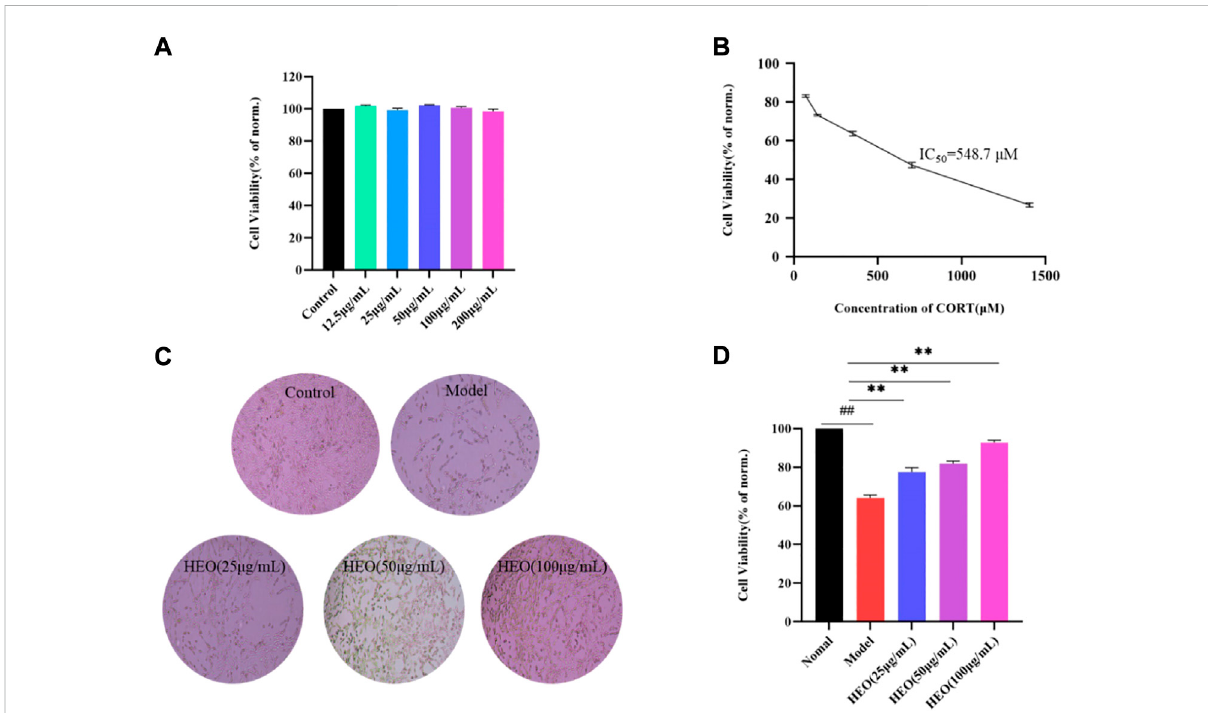
FIGURE 9 Protective effects of HEO on CORT-induced PC12 cells. Effects of HEO on the viability of normal PC12 cells (A) ; Effects of various concentrationsofCORTontheviabilityofPC12cells (B) ;TherepresentedcellmorphologyofCORT-inducedPC12cellswithHEO(×100) (C) .Effects ofHEO(25 μ g/ml,50 μ g/ml,and100 μ g/ml)ontheviabilityofCORT-inducedPC12cells (D) .Fordataexpressedasmean± SEM( n =3). ## p < 0.01vs control group; ** p < 0.01 vs model